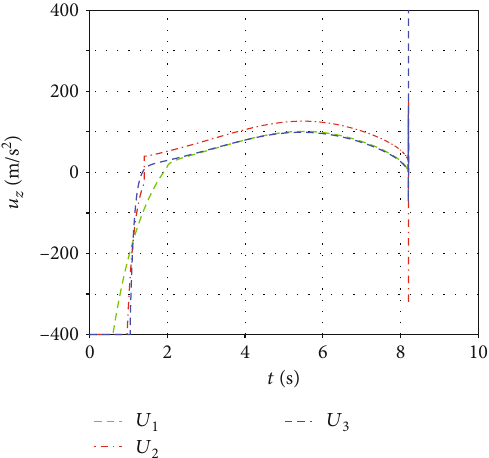
Figure 18: Acceleration instruction u